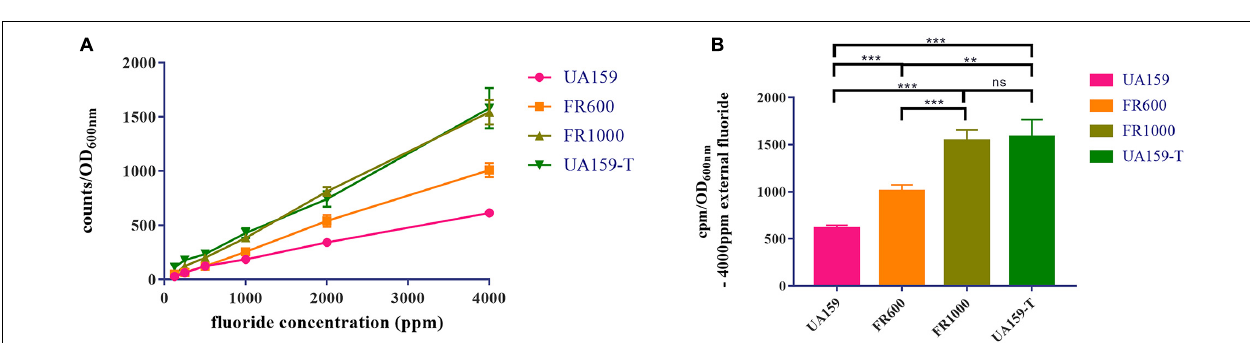
FIGURE 4 | Measurement of relative intracellular fluoride concentration. (A) The relative intracellular fluoride concentration increased alongside the external fluoride concentration. (B) With the existence of 4,000 ppm external fluoride, relative intracellular fluoride concentrations of fluoride resistant strains (FR1000 and UA159-T) were higher than UA159. The significance level ( α ) was set at 0.05 (One-way ANOVA, Dunnett’s T3, IBM SPSS Statistics 24). N = 6 per group. ** indicates P < 0.01. *** indicates P < 0.001. ns indicates no significant difference.